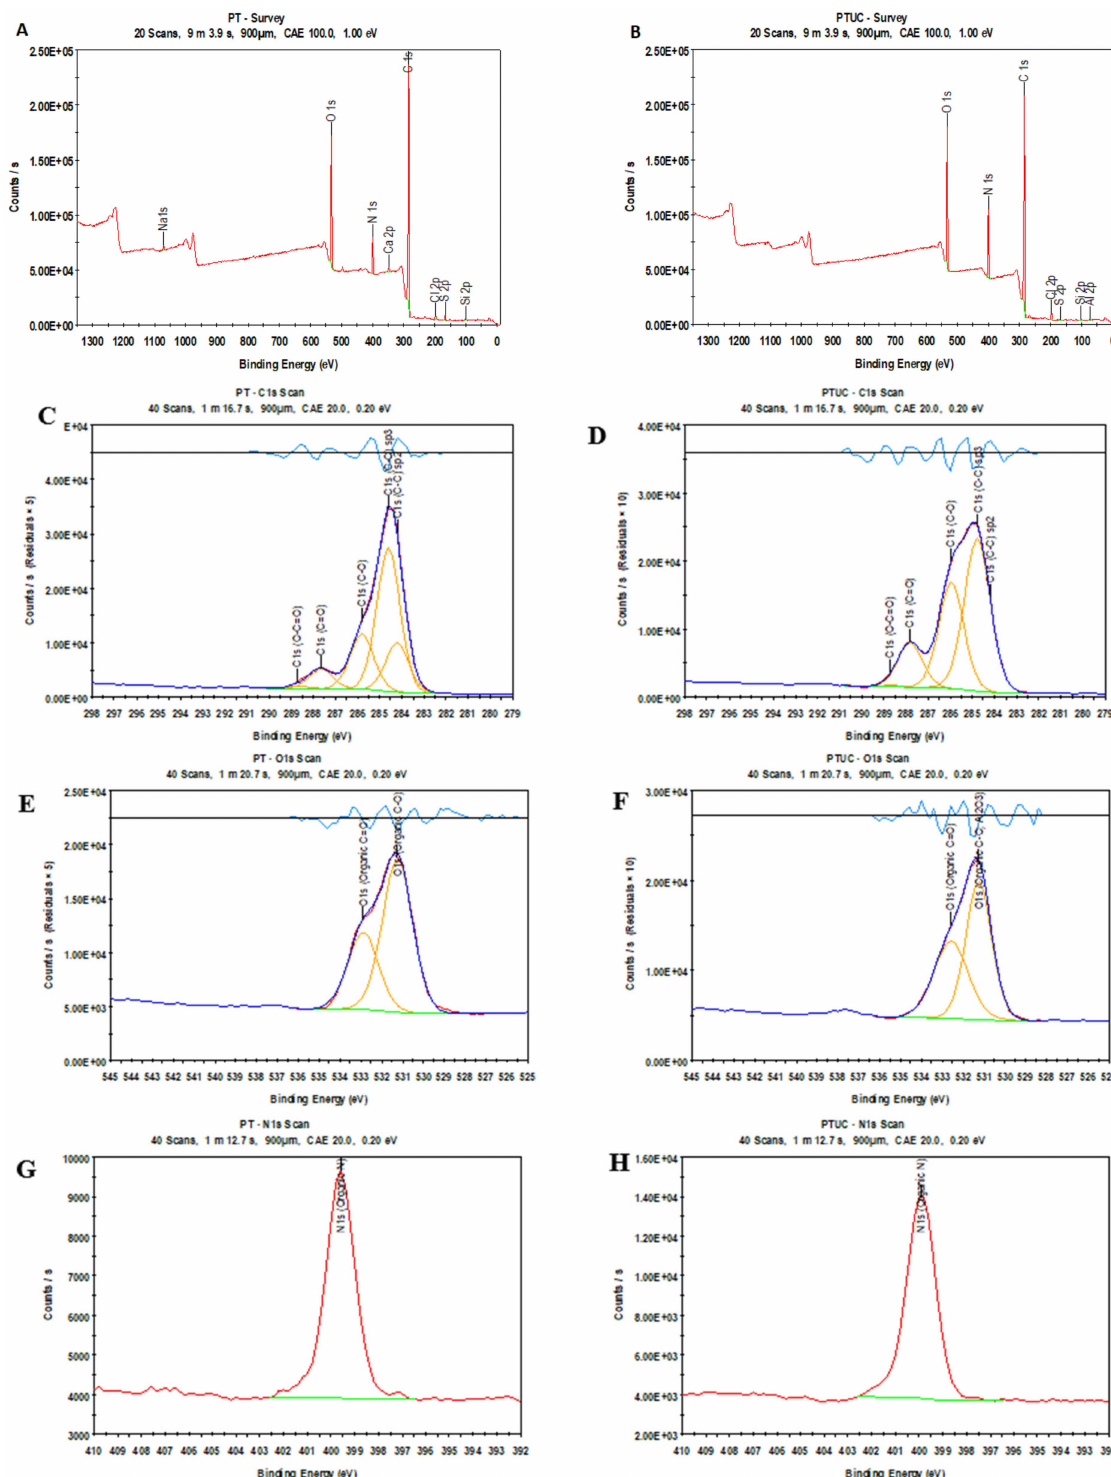
Figure 3. Survey spectrum of PT ( A ) and PTUC ( B ). C 1s, O 1s, and N 1s core-level spectra of PT ( C , E , G ) and PTUC ( D , F , H ). For PT, the intensity of the O (1s), N (1s), and C (1s) peaks was at 531.9, 339.9, and 284.9 eV, respectively, while for PTUC, the intensity of the O (1s), N (1s), and C (1s) peaks was at 531.4, 339.8, and 284.9 eV, respectively. This confirmed the formation of the polyamide membrane in both cases